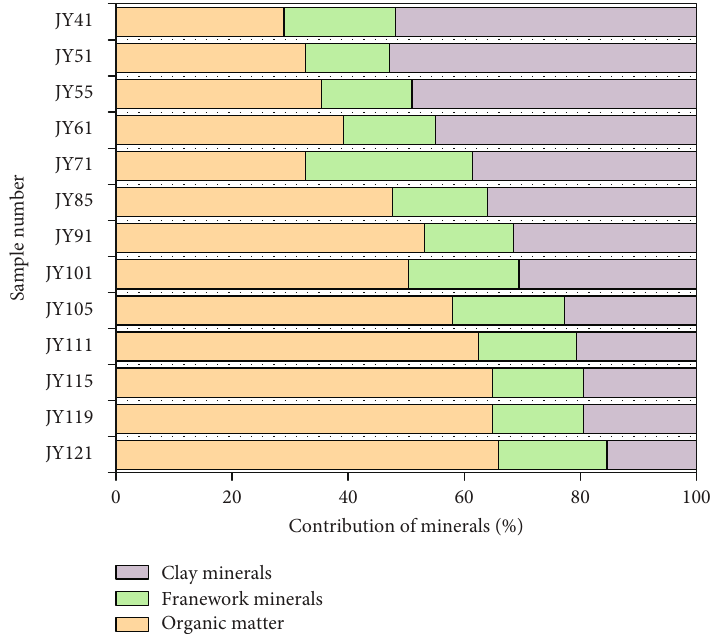
Figure 11: The contribution of organic matter, framework minerals, and clay minerals to the total porosity of the studied